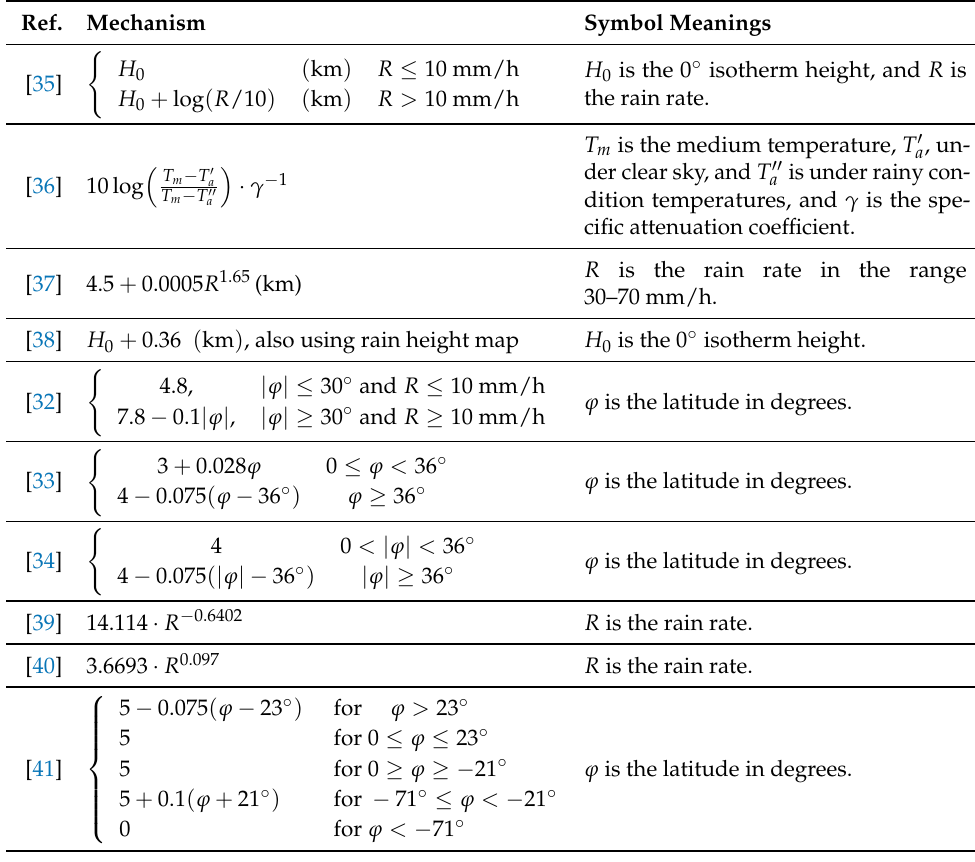
Table 3. Different techniques to estimate rain height.